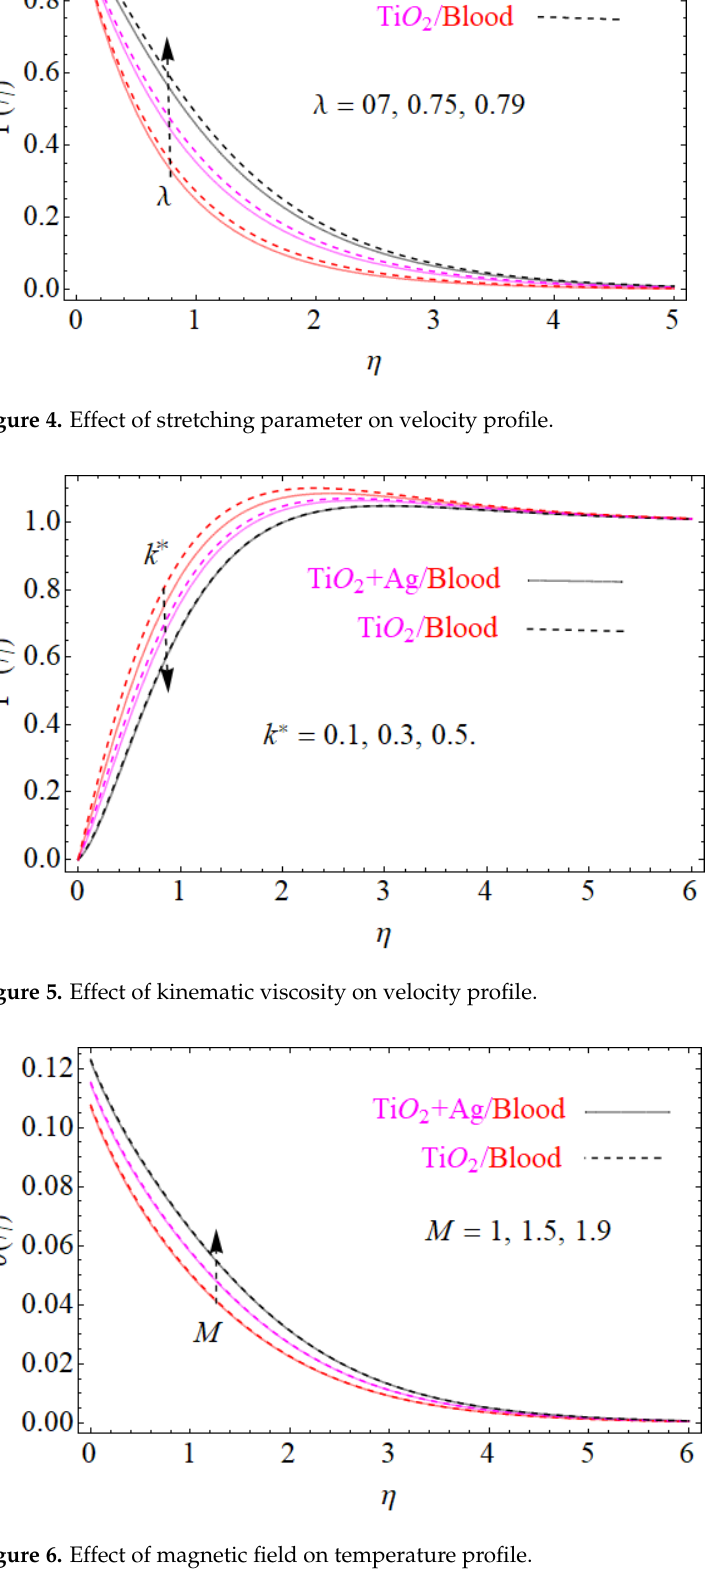
Figure 7. Effect of Prandtl number on temperature profile. By enhancing the 𝑃𝑟 , it decreases the temperature profile. In fact, the thickness of the momentum boundary layer is bound to be larger than that of the thermal boundary layer, or the viscous diffusion is larger than the thermal diffusion and therefore, the larger amount of the 𝑃𝑟 reduces the thermal boundary layer. Figure 8 shows the impact of the Eckert number versus the temperature field.